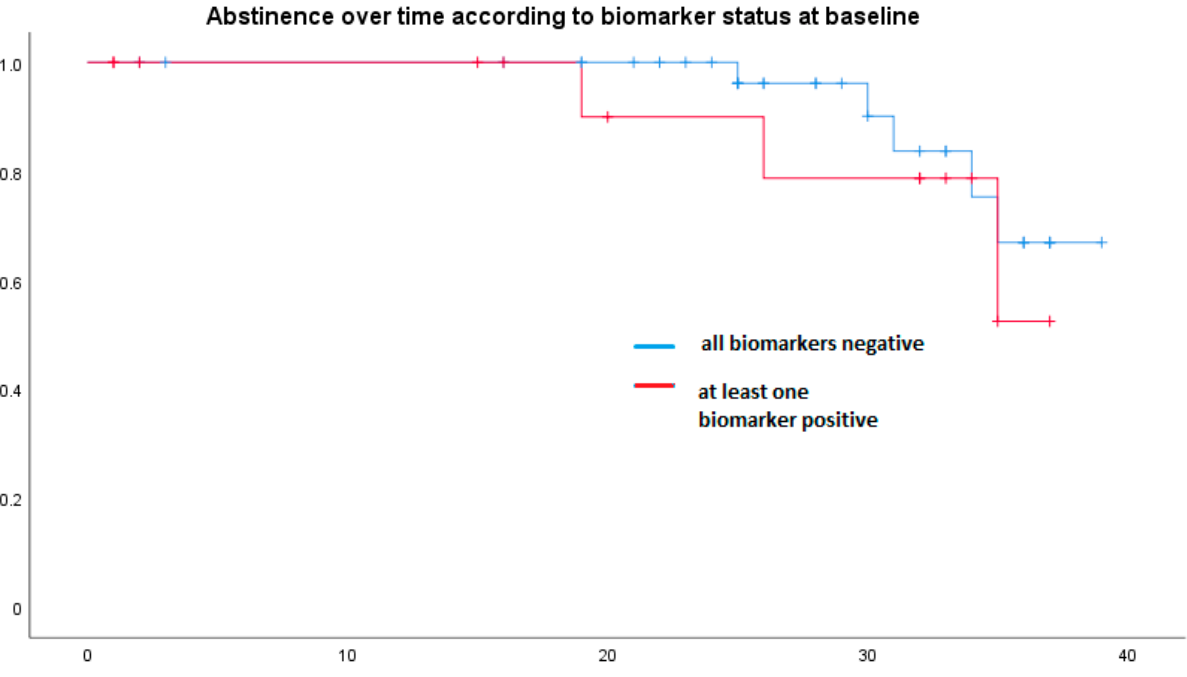
Figure 2. Kaplan–Meier plot depicting abstinence according to biomarker status at baseline.